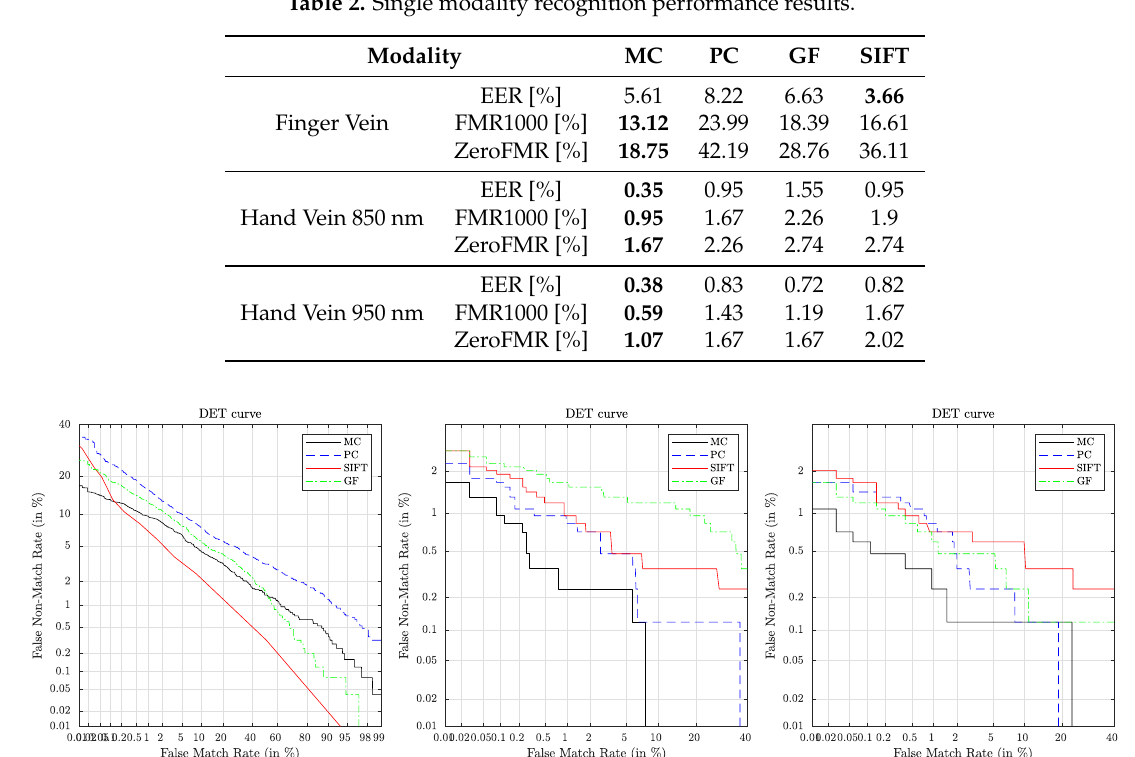
Table 2. Single modality recognition performance results.